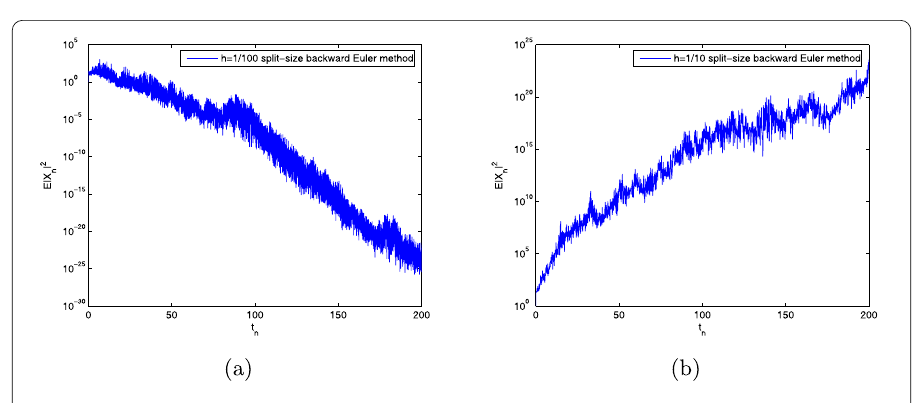
Figure 3 The split-step backward Euler method with ( a ) h = 1/100; ( b ) h =